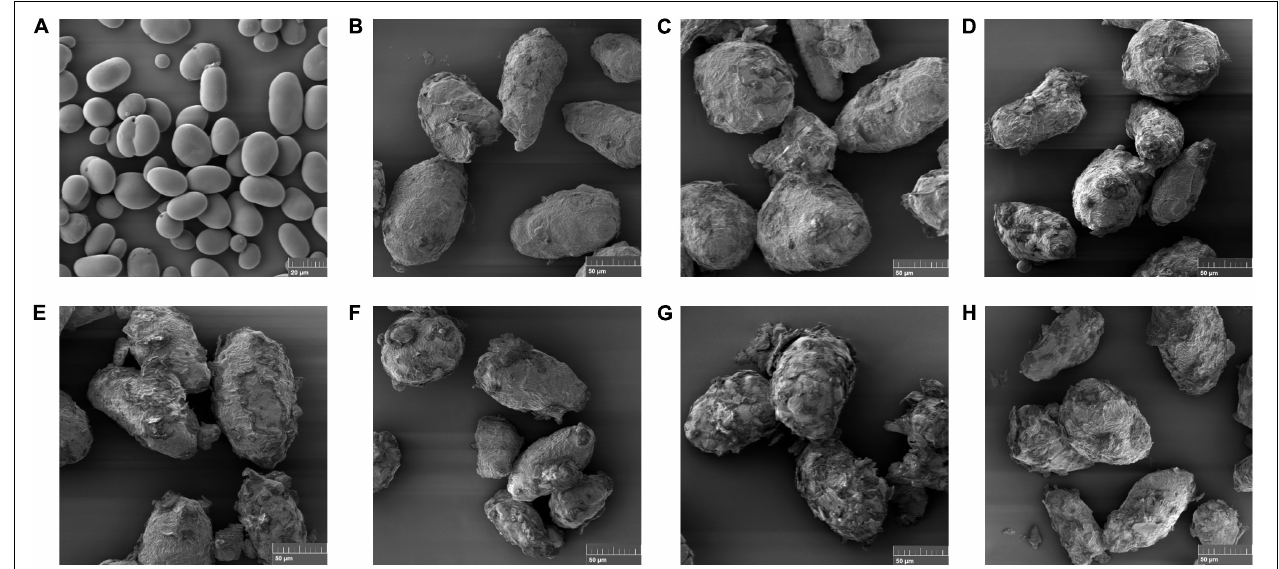
FIGURE 4 | Scanning electron microscopy images (scale 20–50 µ m) of isolated native starch (scale = 20 µ m) (A) , control (B) , and high pressure processed cooked chickpeas (where, (C) = 200 MPa, 1 min; (D) = 200 MPa, 5 min; (E) = 400 MPa, 1 min; (F) = 400 MPa, 5 min; (G) = 600 MPa, 1 min; and (H) = s 600 MPa, 5 min).